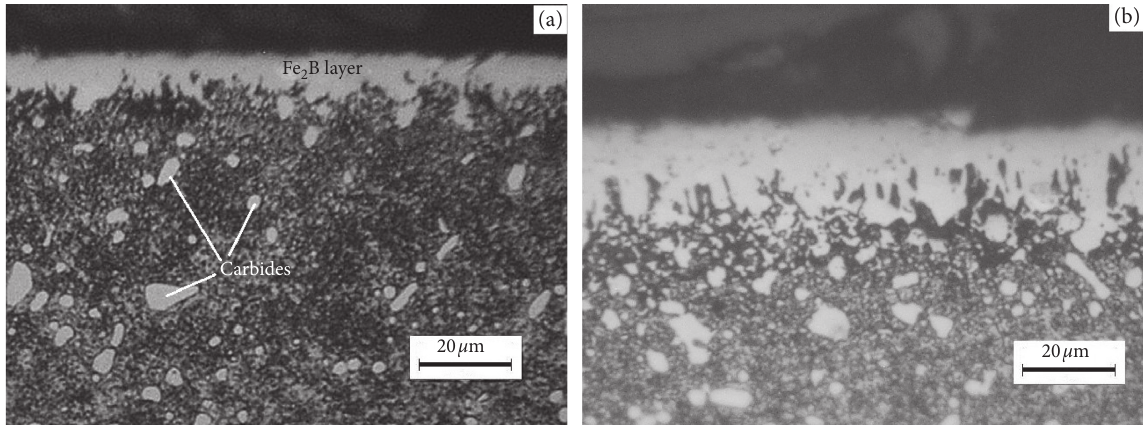
Figure 10: Cross-sectional views of AISI W2 steel borided by optical micrograph: (a) 1259 for 3h and (b) 1148K for 1 h. Table 3: Prediction and estimate values of the Fe 2 B layer thickness. Temperature (K)